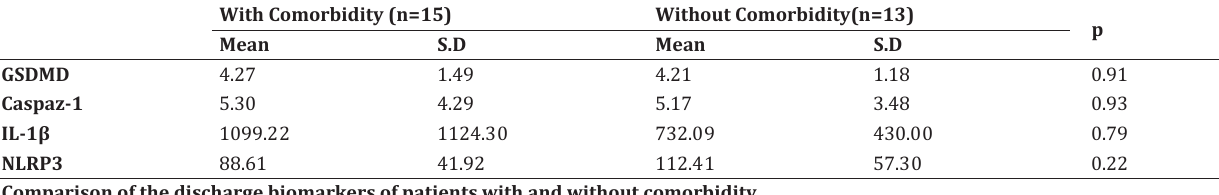
With Comorbidity